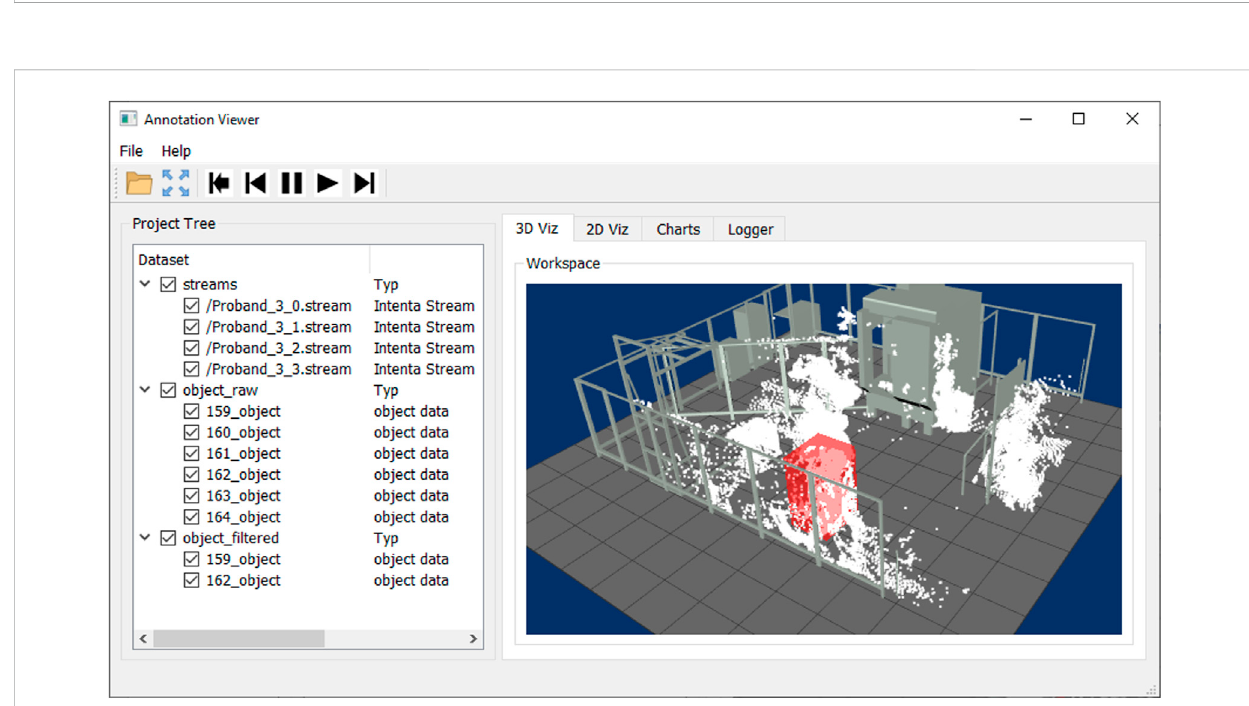
FIGURE 2 Graphical user interface for displaying sensor data sets and annotation